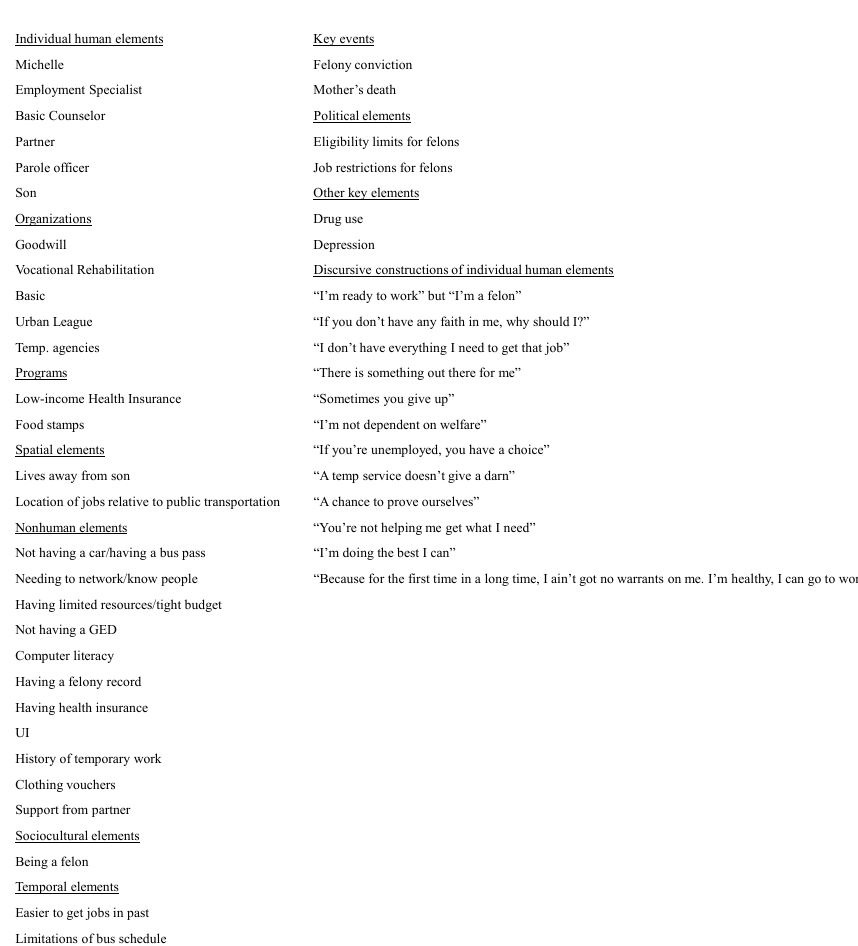
Figure 2. Ordered situational map—Michelle.